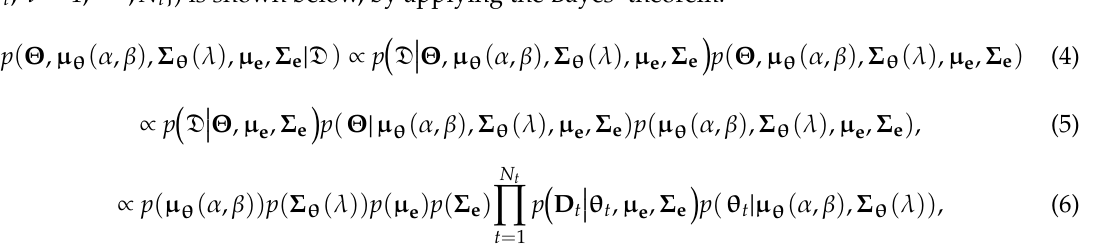
(cid:17) p ( Θ | µ θ ( α , β ) , Σ θ ( λ ) , µ